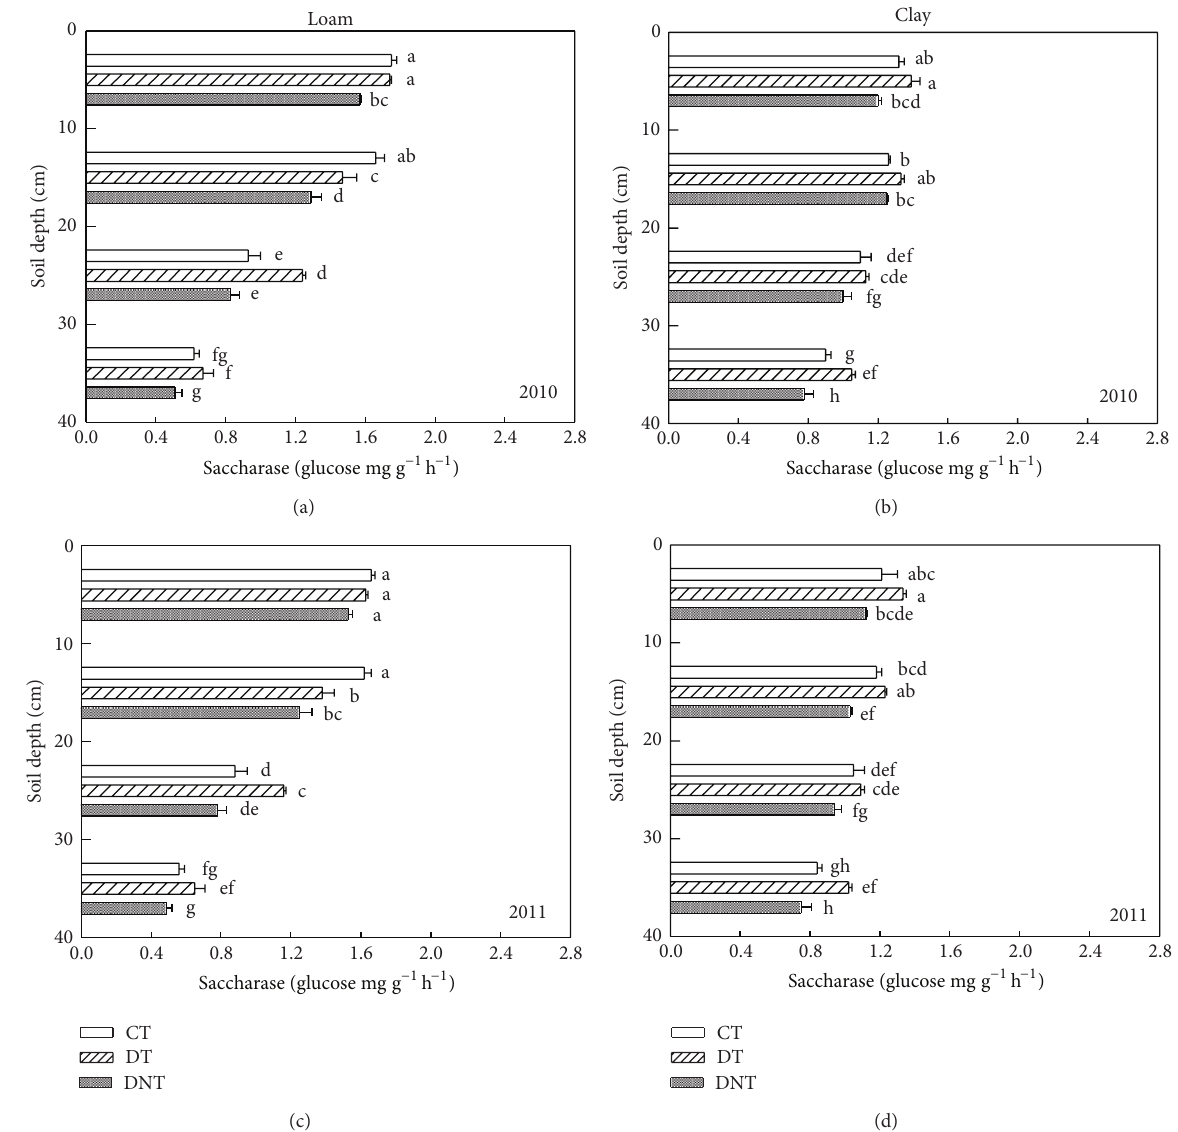
Figure 6: Effects of tillage and straw returning on soil saccharase activity. Different small letters indicated significant difference at 𝑃 < 0.05 according to Duncan’s test. CT represented conventional tillage, moldboard ploughed to a depth of 20 cm, and straw was returned. DT represented deep tillage moldboard ploughed to a depth of 30 cm and straw was returned. DNT represented deep tillage moldboard ploughed to a depth of 30 cm and straw was